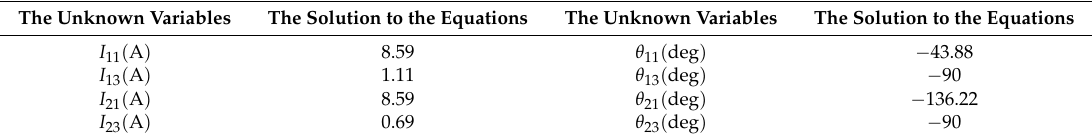
Table 1. The optimum solutions to the fault-tolerant currents under single-phase open-circuit fault type. The Unknown